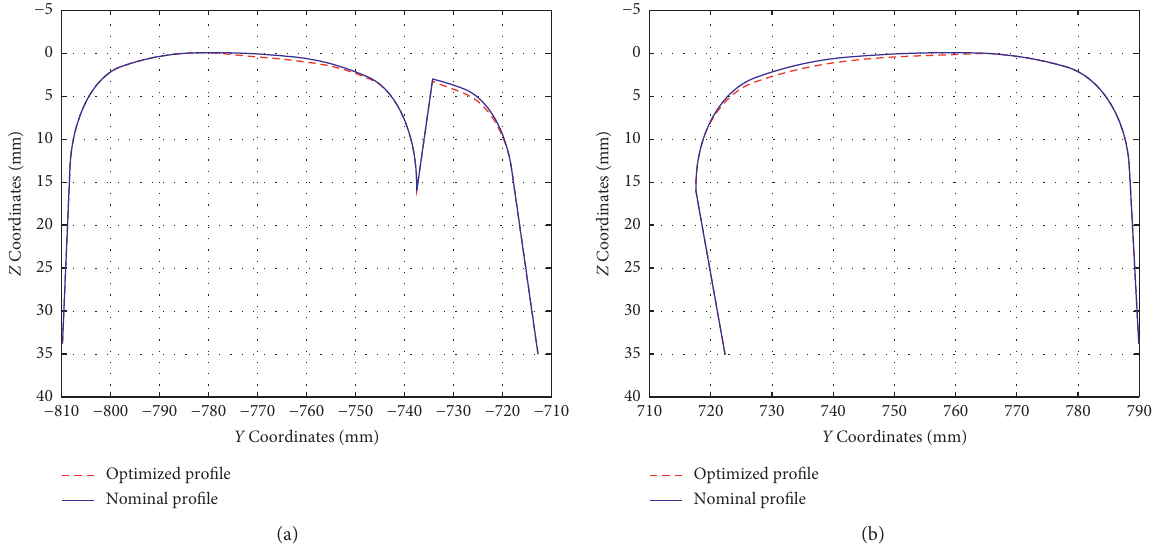
Figure 12: Comparison of rail profiles before and after optimization: (a) switch rail and (b) stock rail.